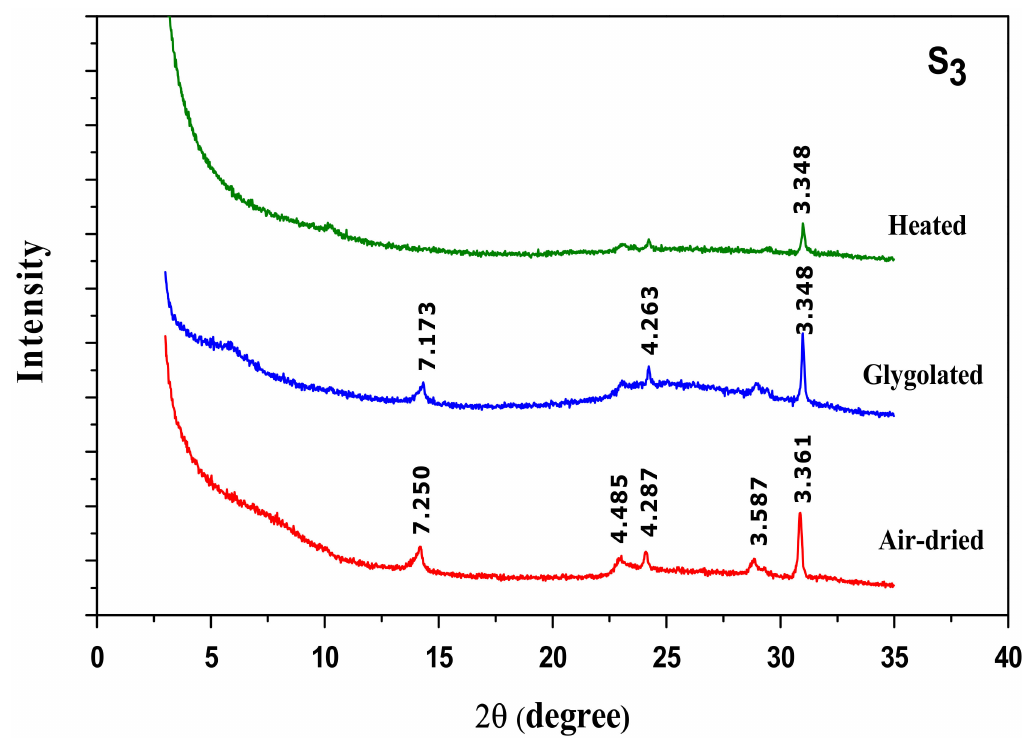
Figure 7. XRD patterns of oriented activated clay specimens prepared under different conditions: S 1 (low conditions), S 2 (average conditions) and S 3 (strong